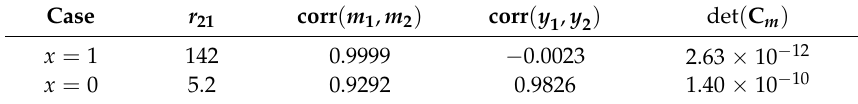
Table 1. 100-experiment averages for the design via Equation (26) on G 1 ; r 21